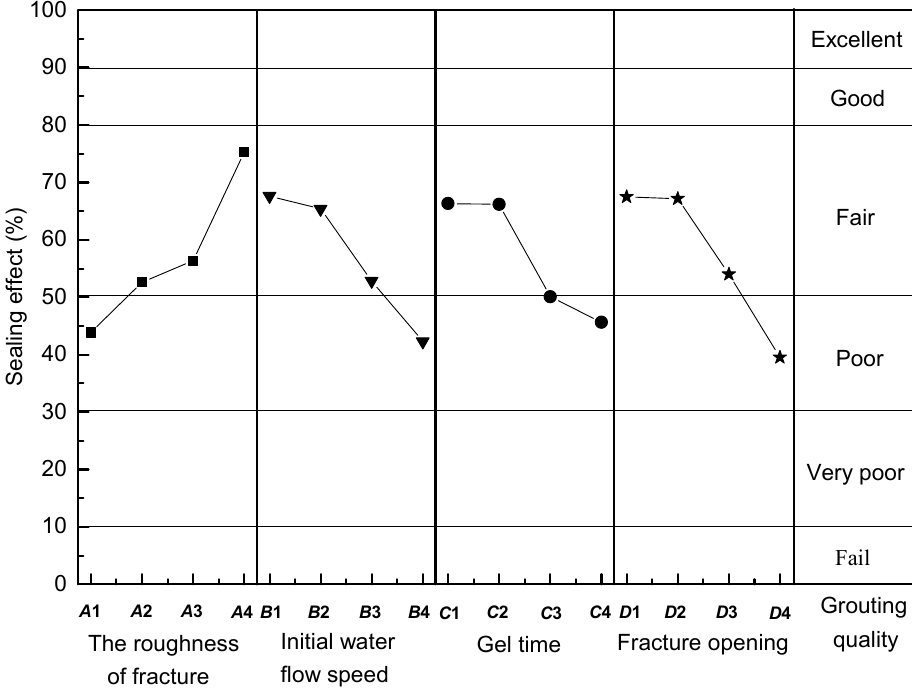
Figure 11. The analysis chart of SE for four factors.